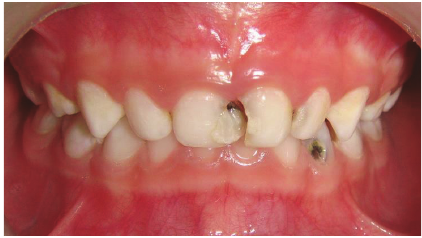
Figure 6: Postoperative photograph (Case 2 ).